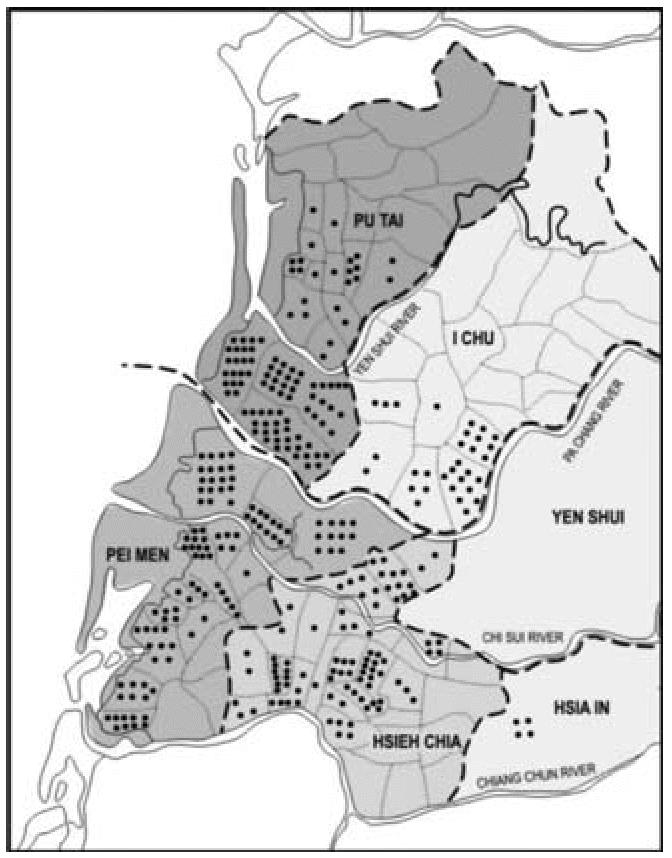
Distribution of BFD cases in the 1960s by township [adapted from Ch’i and Blackwell (1968) with permission of Oxford University Press].